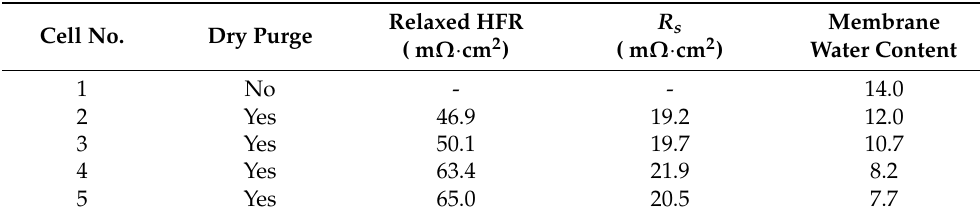
Table 2. Membrane water content after HFR